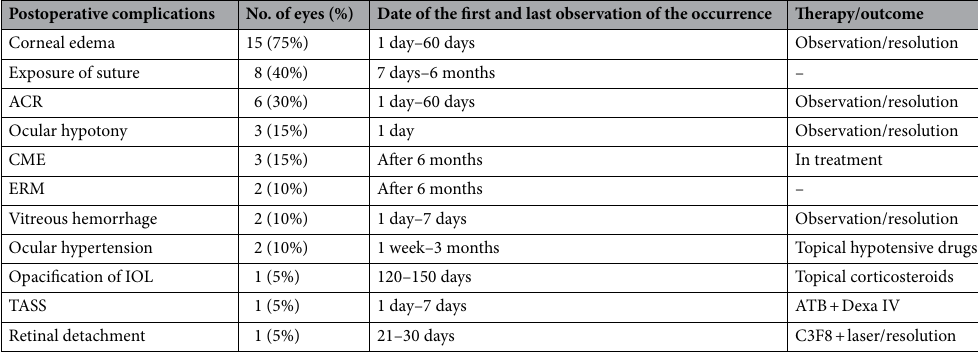
Table 3. Postoperative complications. ACR anterior chamber reaction, CME cystoid macular edema, ERM epiretinal membrane, TASS toxic anterior segment